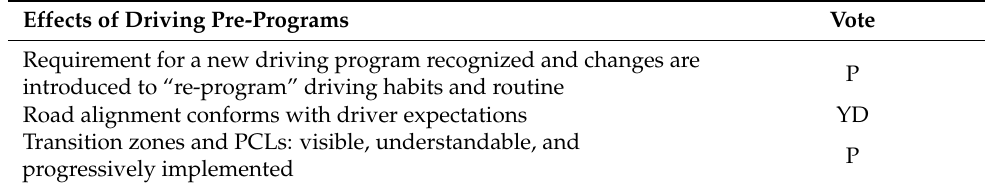
Table 13. Evaluations of the “effects of driving pre-programs” investigation topic. Effects of Driving